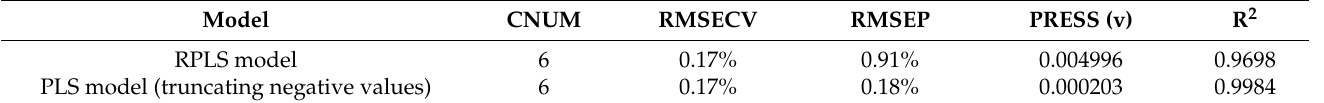
Table 3. FAME quantification PLS model results; all diesel blends. All diesel blends.